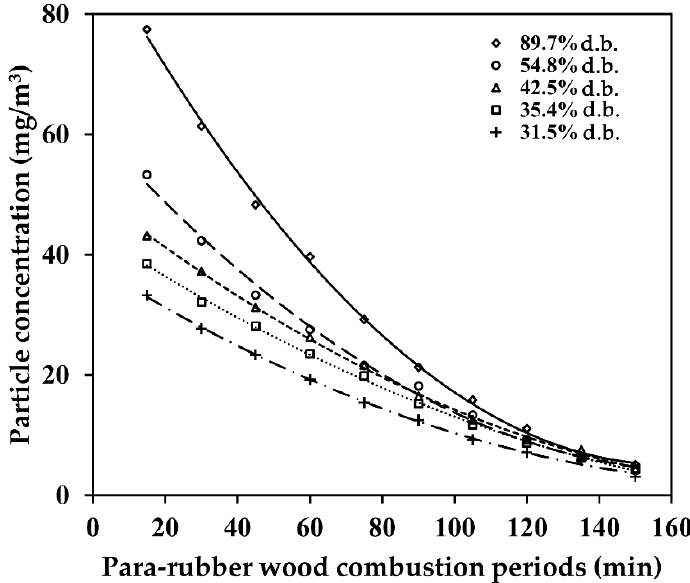
Figure 5. TPMC emission from the para rubber wood combustion for different wood moisture con- tents.